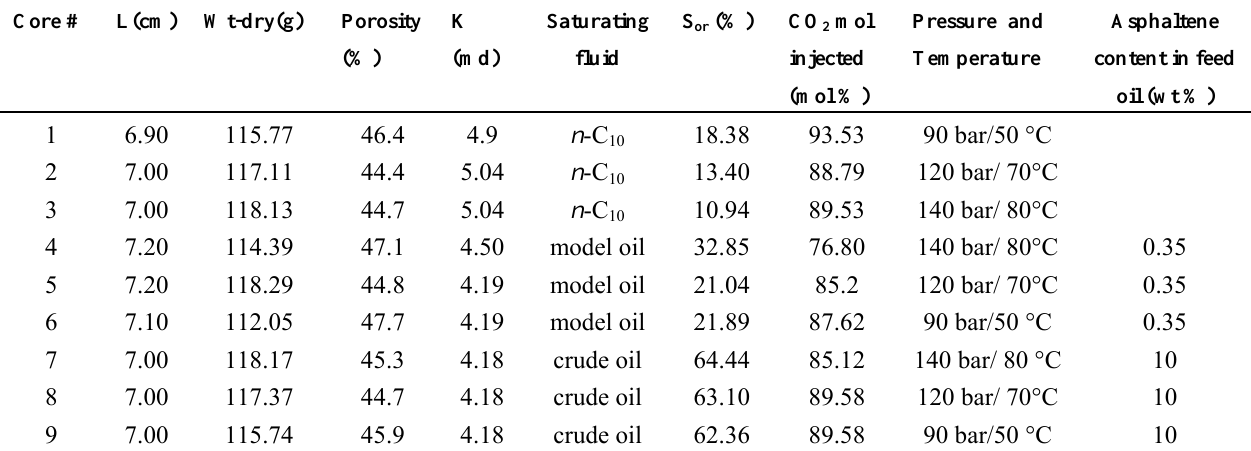
Table 2. Core descriptions and fluid